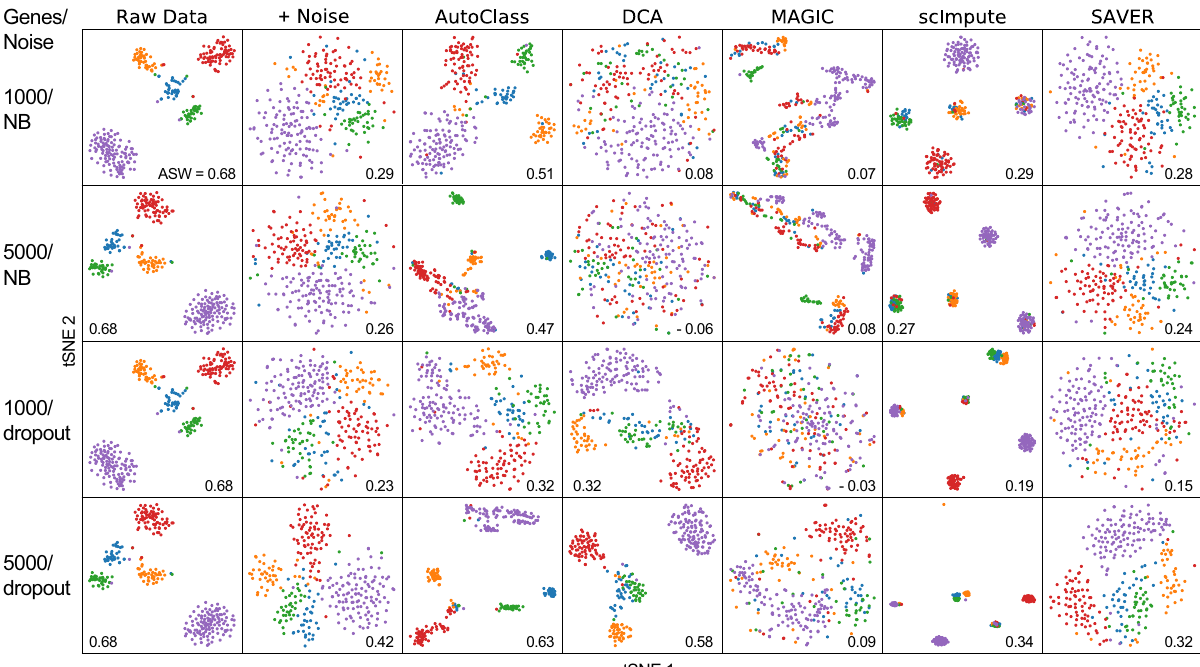
Fig. 8 Imputation results for Tian et al cell mixture dataset. The rows are different feature sizes (genes) and additional noise types, i.e. dropout vs NB (Negative